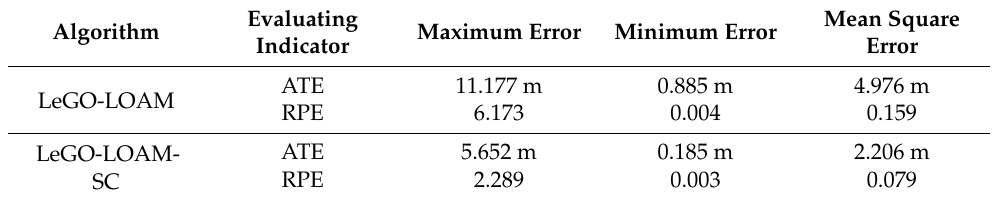
Table 2. Comparison of absolute trajectory error and relative position error.